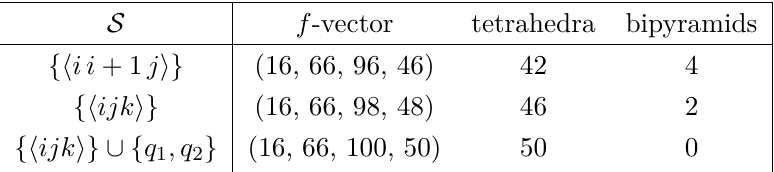
Table 1. Different possible fans for Gr(3 , 6) with their f -vectors as well as a characterisation of the dimension two